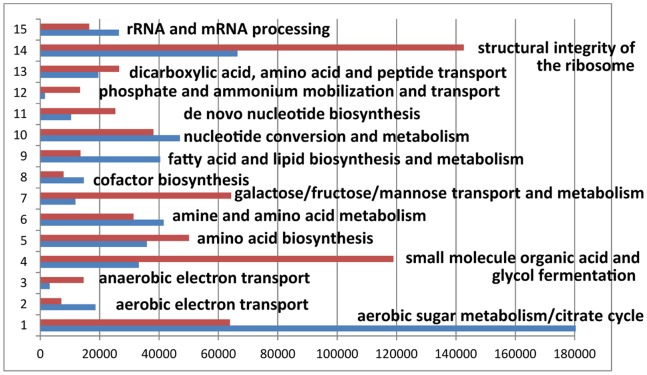
Global adaptation of EHEC cells to the intestinal milieu.Fifteen biological role categories, as defined in Dataset S1, are displayed in the graph. The bar length represents the sum of APEXi quantities of all proteins with a statistically significant abundance change (in vitro versus in vivo) assigned to a given biological role category. Blue bars represent the in vitro (cell culture) growth, red bars the in vivo (intestinal) environments.